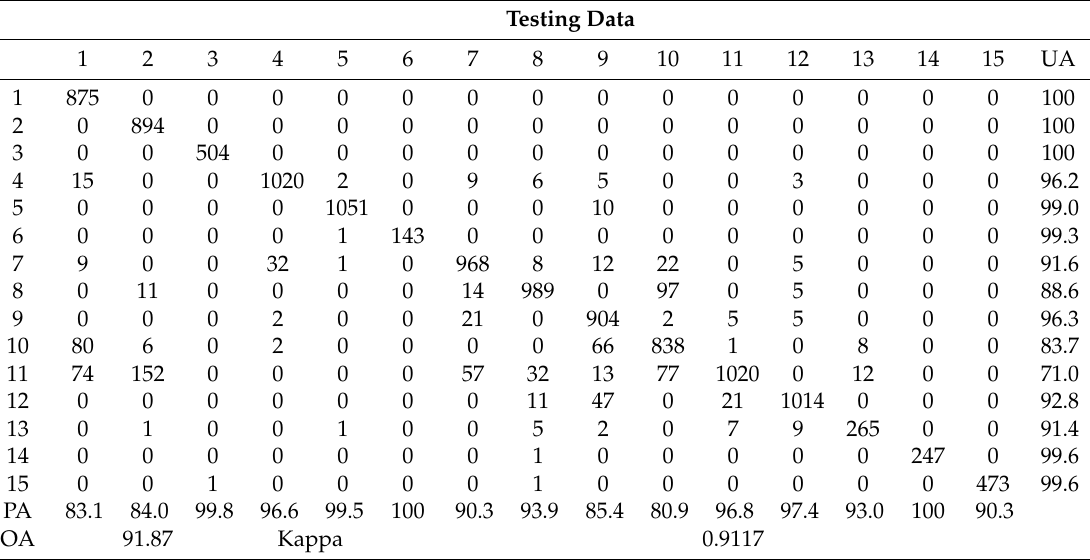
Table 4. Confusion matrix of the proposed